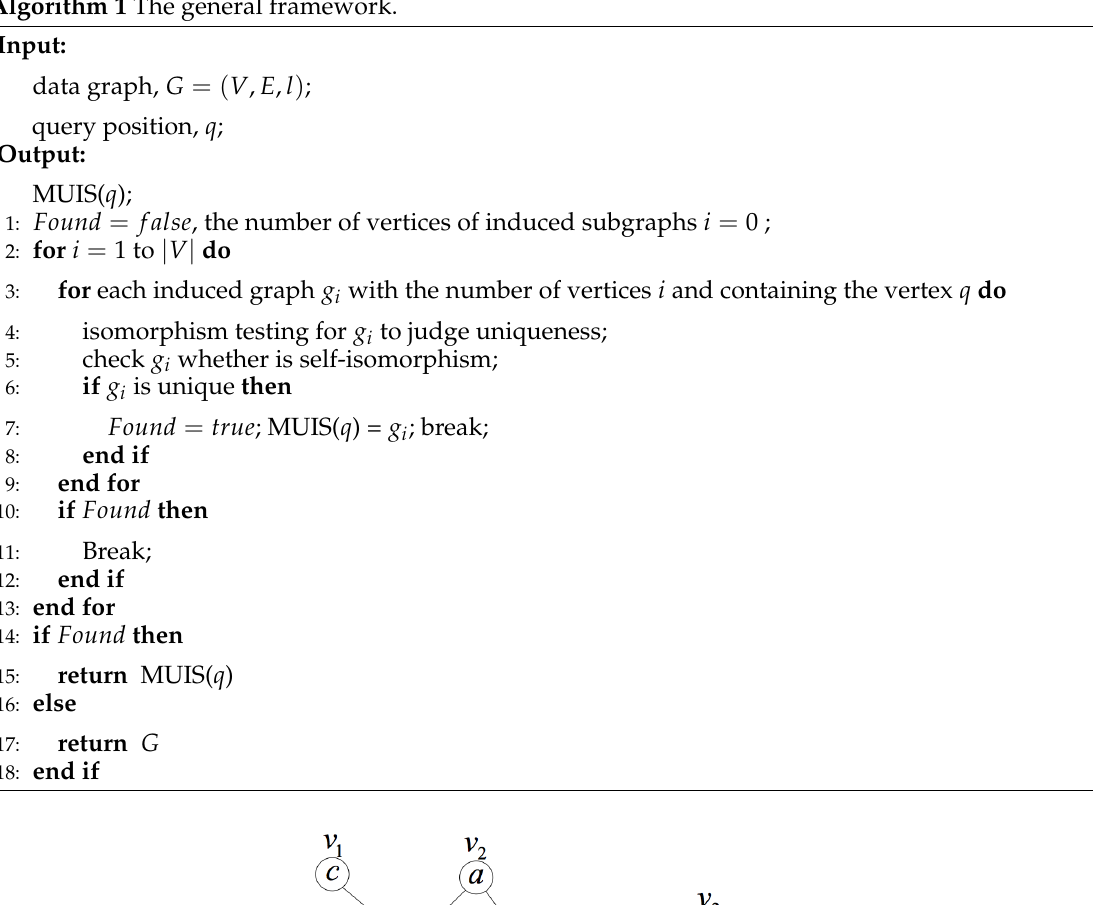
Algorithm 1 The general framework.